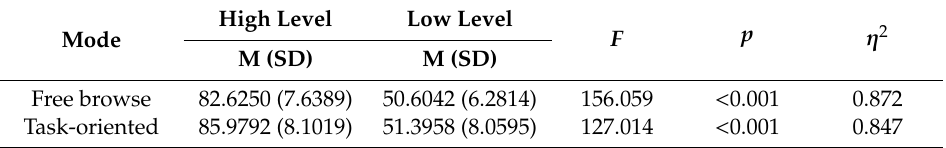
Table 1. Repeated measures ANOVA of interactive experience.